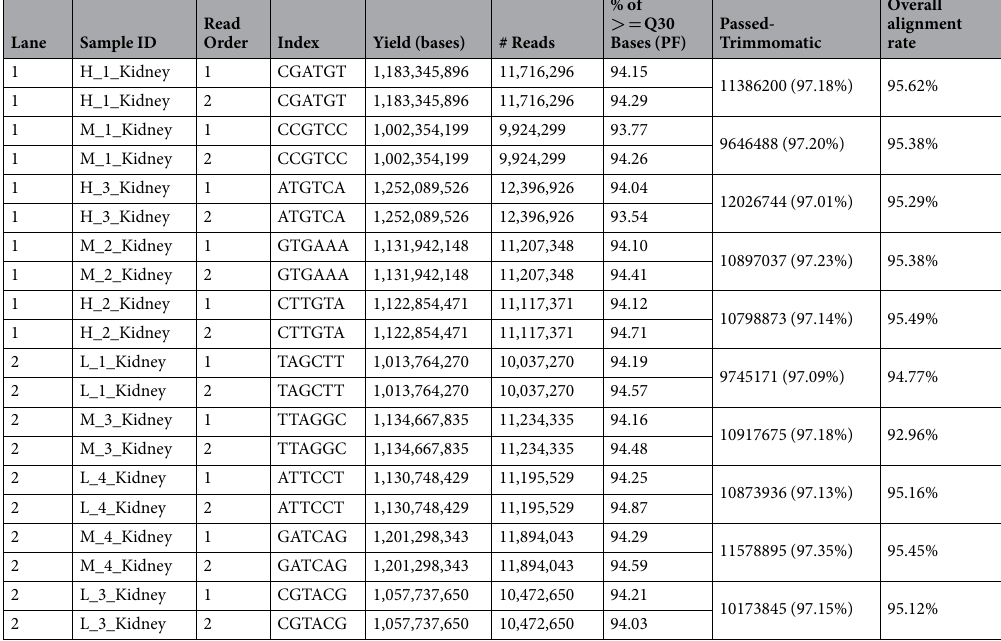
Table 2. RNA-seq reads and mapping rate of kidney samples from ten chickens fed diets containing different Ca